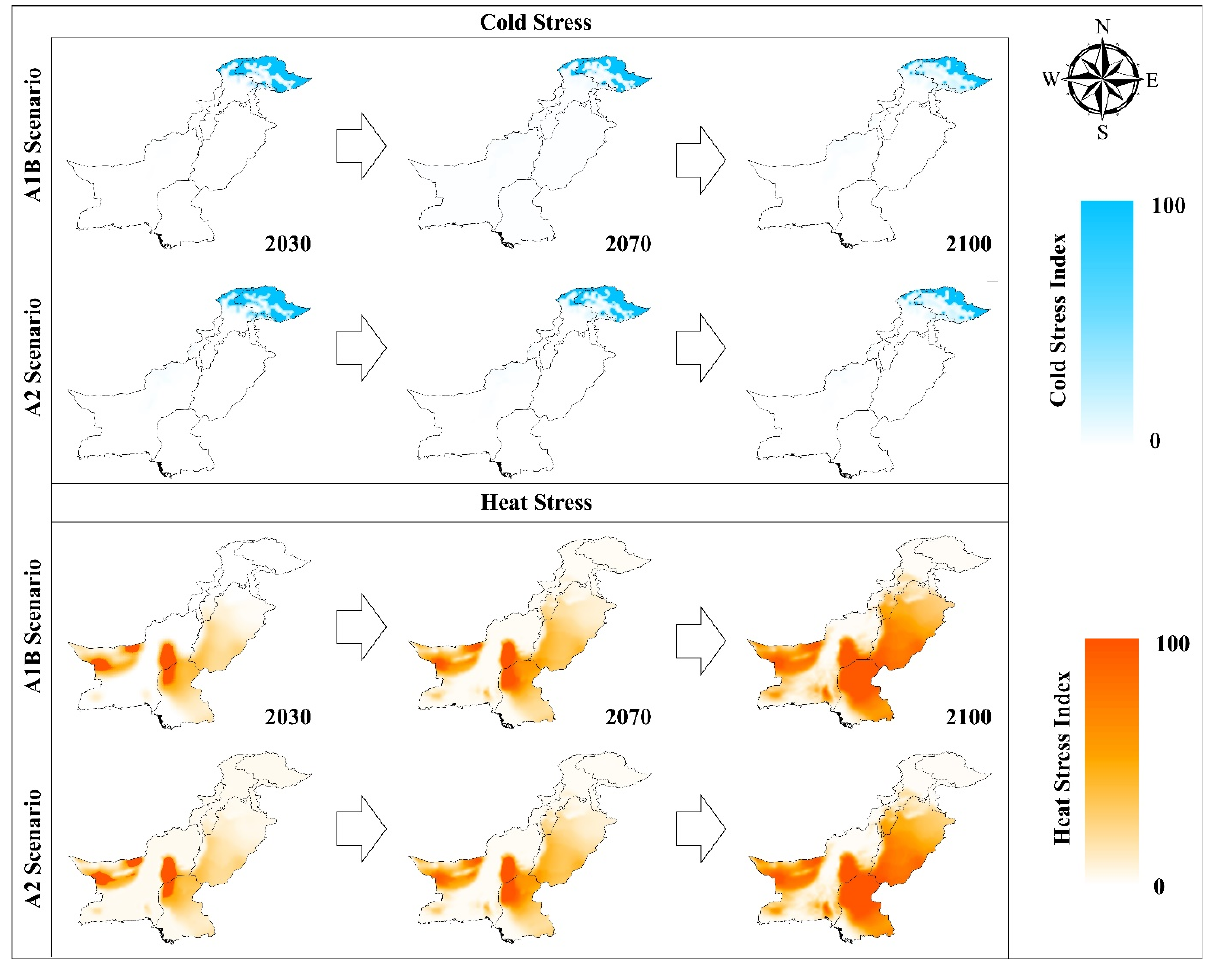
Figure 6. The predicted region in Pakistan where Aelosthes sarta survival is affected by cold and heat stress for different periods under the scenarios of A1B and A2 climate change.